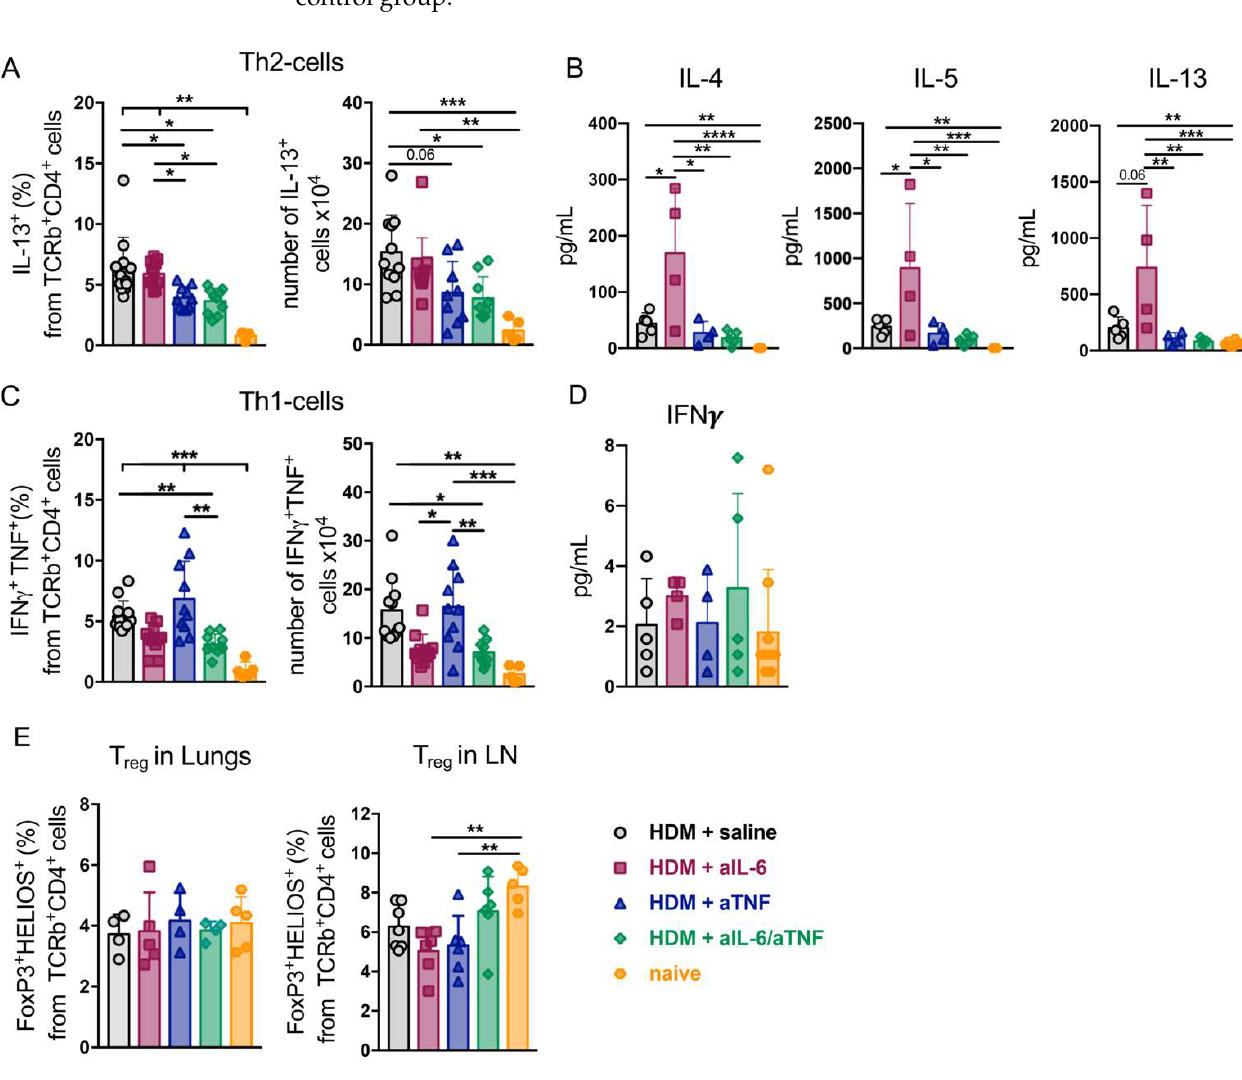
Figure 2. Th2- and Th1-cell inflammatory responses in the lungs of HDM-treated mice with simul- taneous administration of IL-6 and TNF inhibitors. ( A ) Frequency (%) of Th2-cells (IL-13 + ) among TCRb + CD4 + cells in the lungs. ( B ) Protein levels of Th2-associated cytokines (pg/mL) in the BALF were measured by multiplex analysis on day 14. ( C ) Frequency (%) of Th1-cells (TNF + IFN γ + ) gated on TCRb + CD4 + live cells in the lungs. ( D ) IFN γ production (pg/mL) in the BALF was determined by multiplex analysis on day 14. ( E ) Frequency (%) of Treg cells (FoxP3 + HELIOS + ) in the lungs and lymph nodes (LN). Data represent mean ± SD, 4–12 mice per group with each point representing a single mouse. * p < 0.05; ** p < 0.01; *** p < 0.001; **** p < 0.0001 (one-way ANOVA test was used).